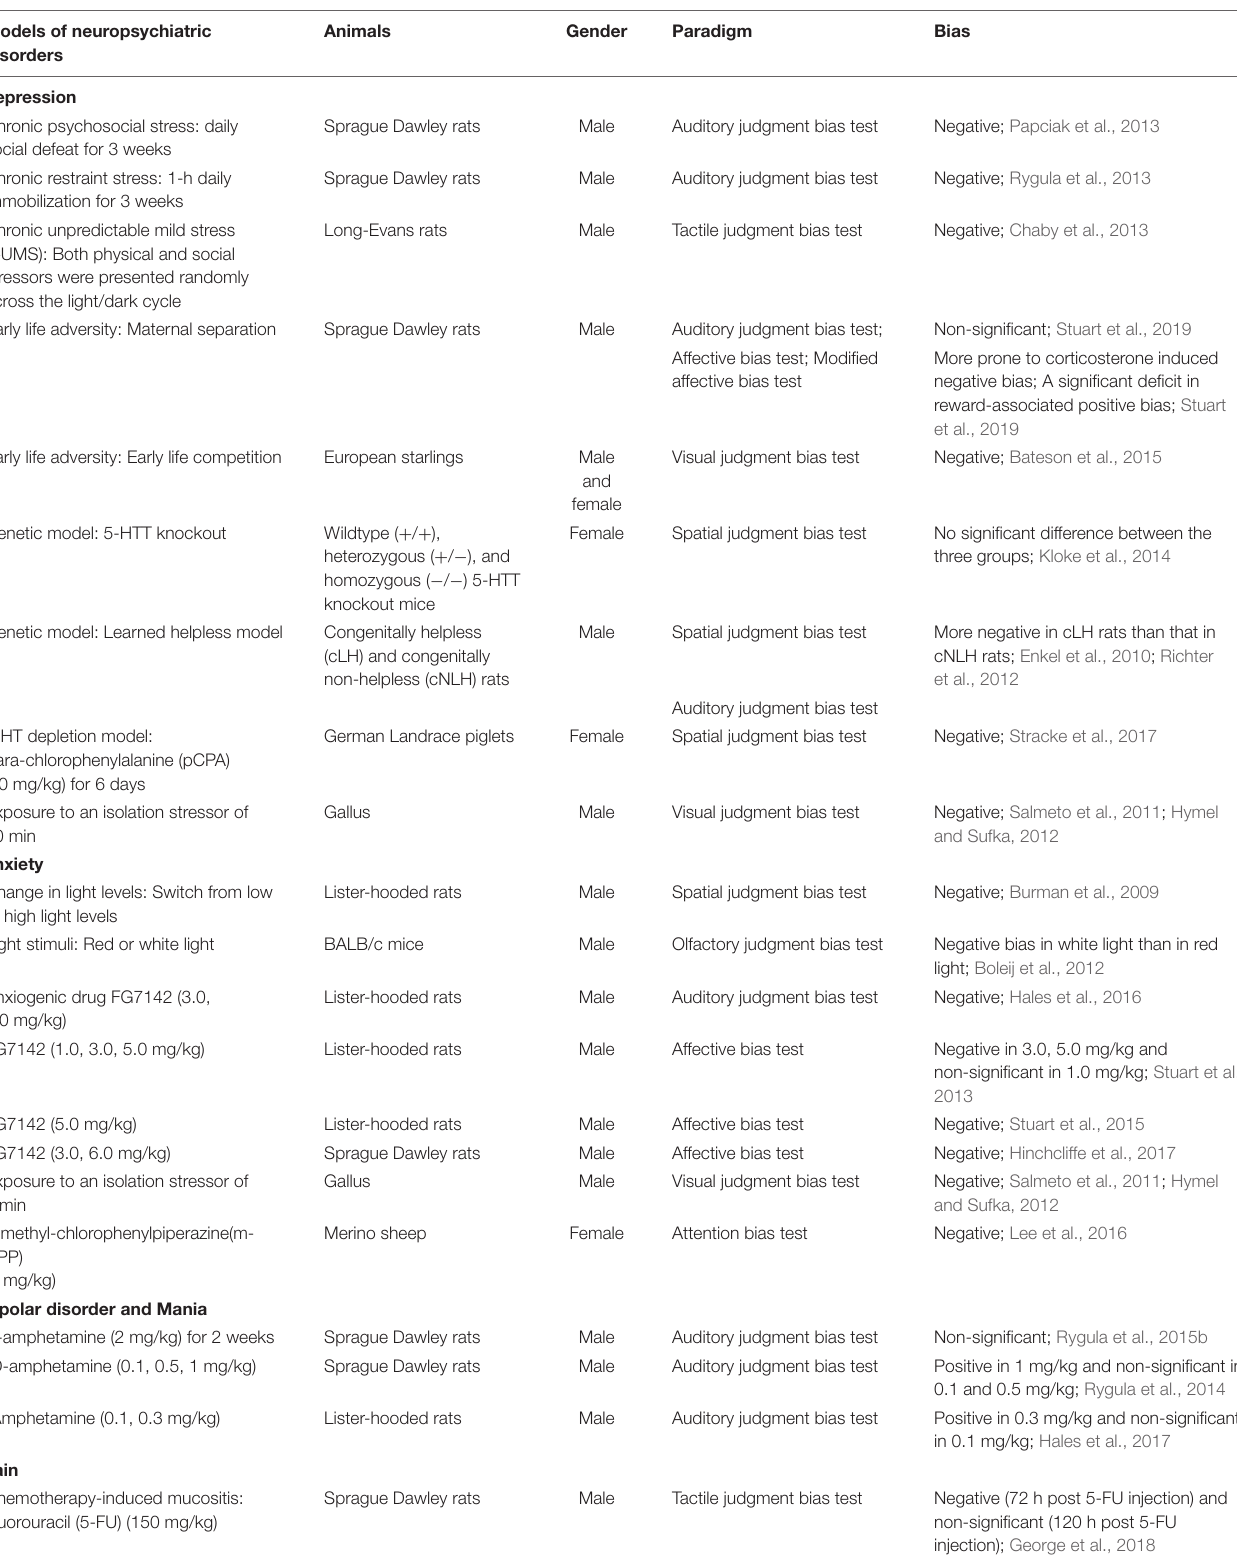
TABLE 2 | Cognitive bias in animal models of neuropsychiatric